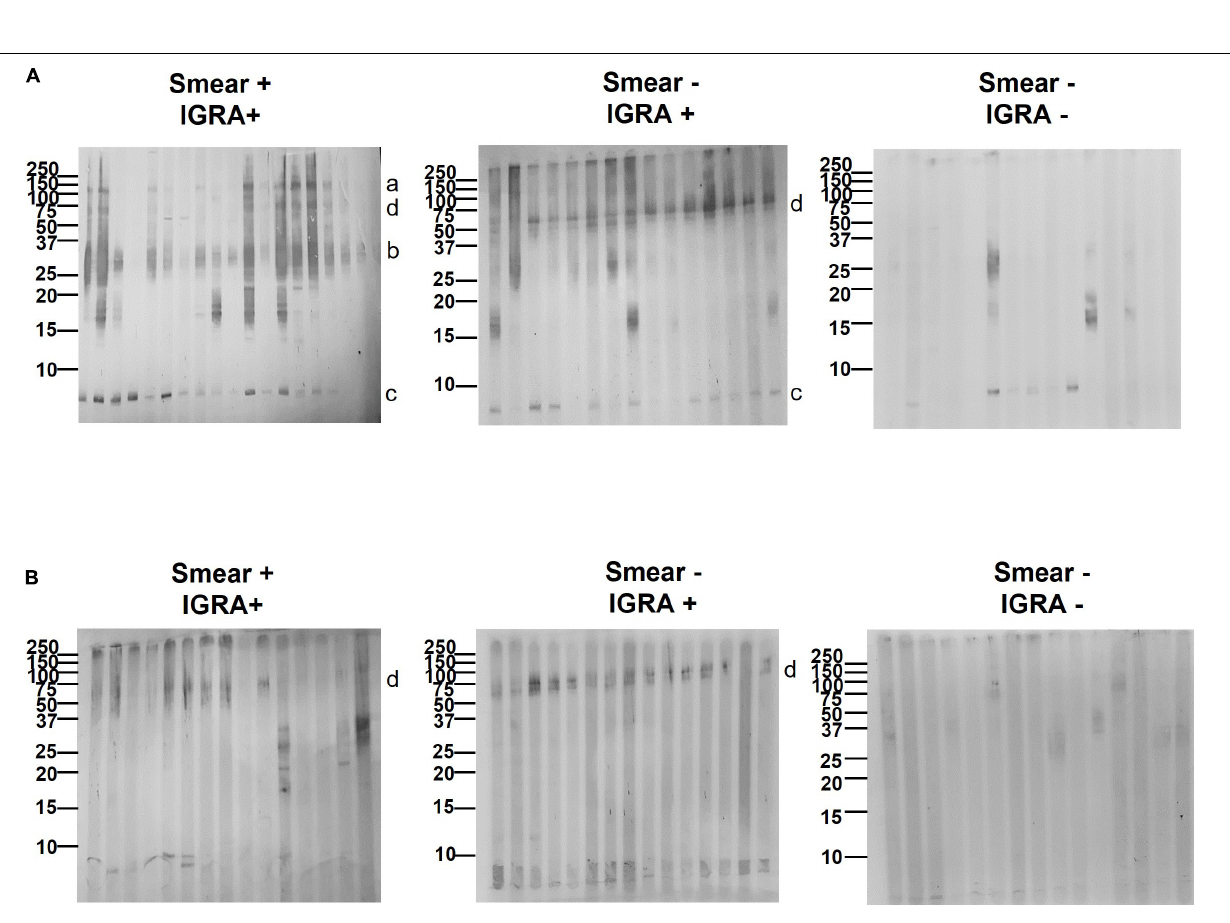
Frontiers in Microbiology |